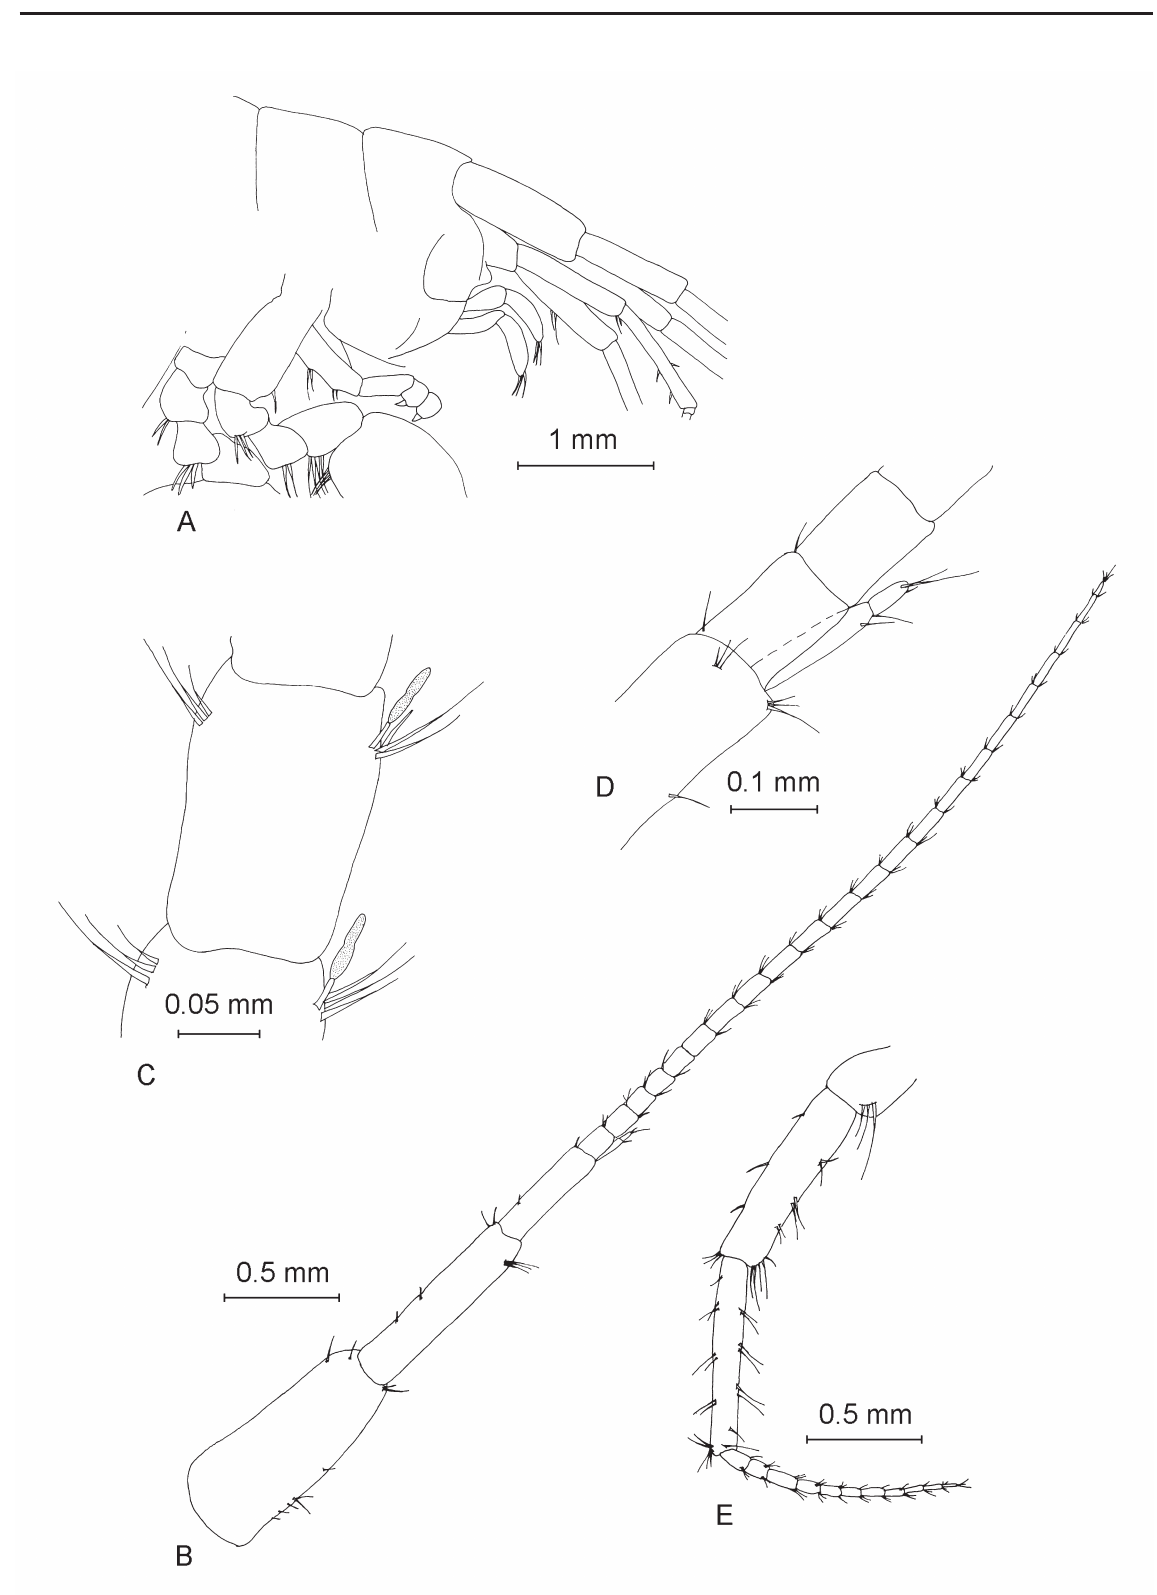
Fig. 9. ♀. A . Head. B . Antenna I. C . Aesthetascs of antenna I. D . Accessory flagellum of antenna I. E . Antenna